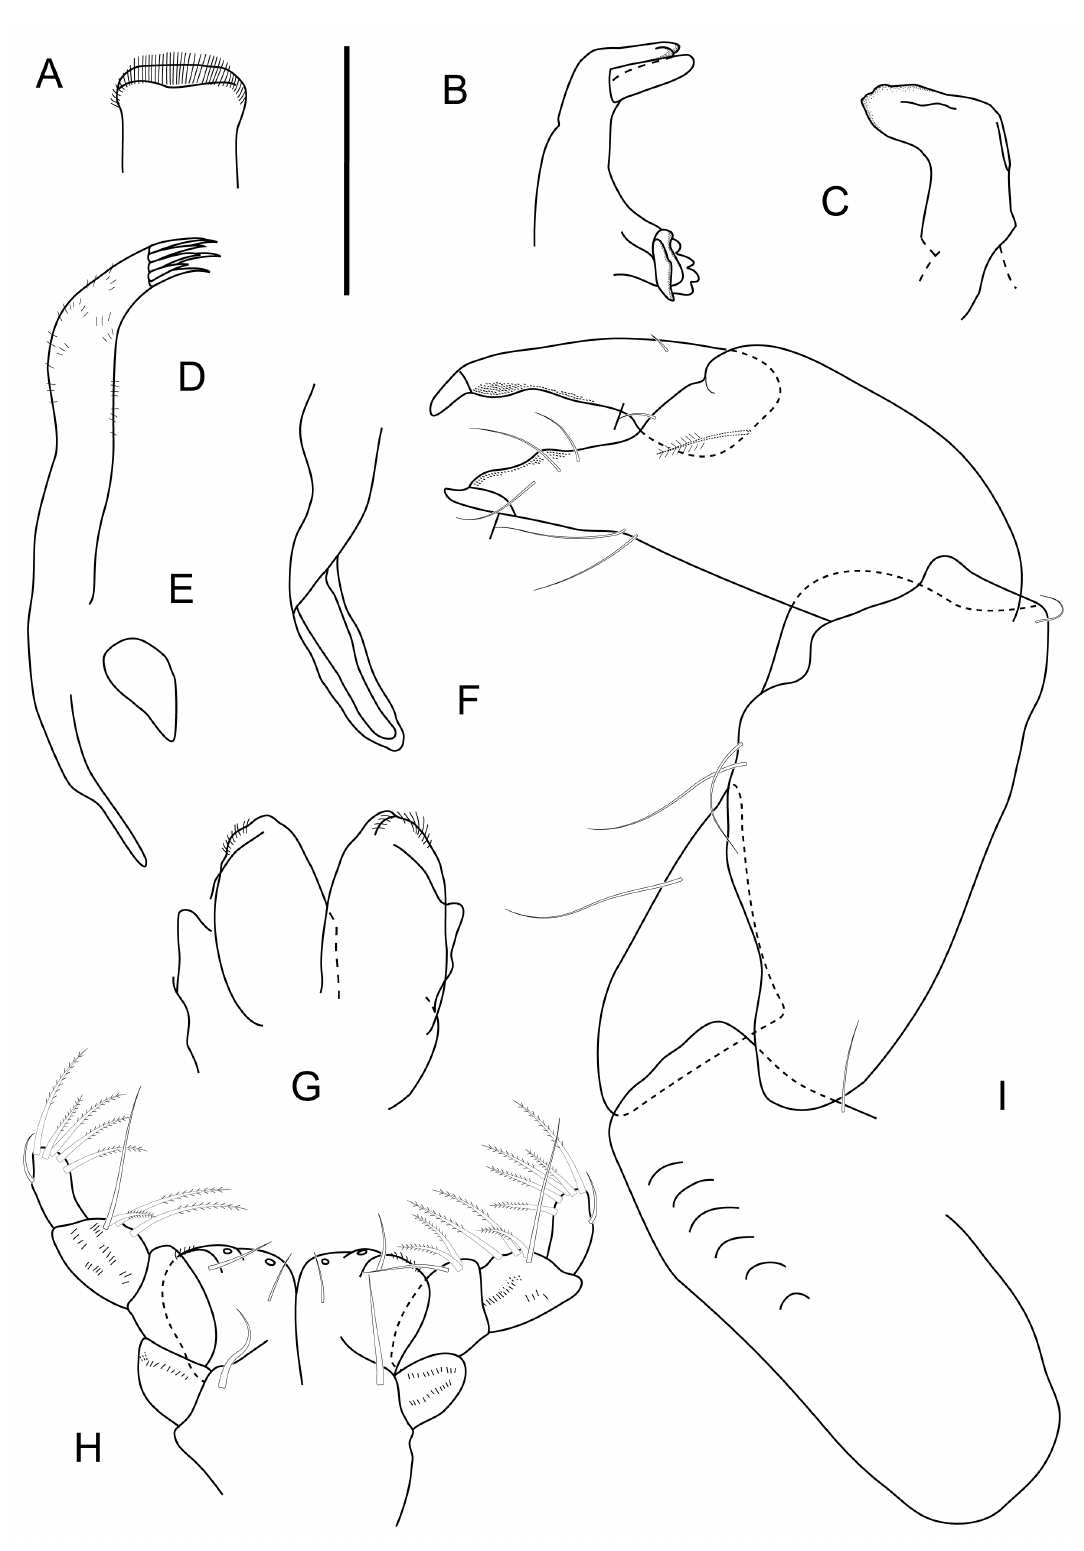
Fig. 6. Typhlotanais longiseta sp. nov., paratype (MZUSP 38015), ♀, dissected. A . Labrum. B . Left mandible. C . Right mandible. D . Maxillule. E . Maxilla. F . Epignath. G . Labium. H . Maxilliped. I . Cheliped. Scale bar = 0.1